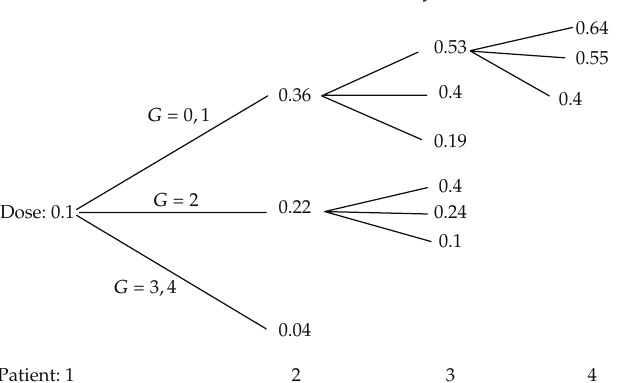
Figure 1: Tree of possible dose allocations for patients 1 and 2 and selected situations for patients 3 and 4. G (cid:7) 0 , 1 corresponds to Y (cid:7) 0, G (cid:7) 2 corresponds to Y (cid:7) 1, and G (cid:7) 3 , 4 corresponds to Y (cid:7) 2 or